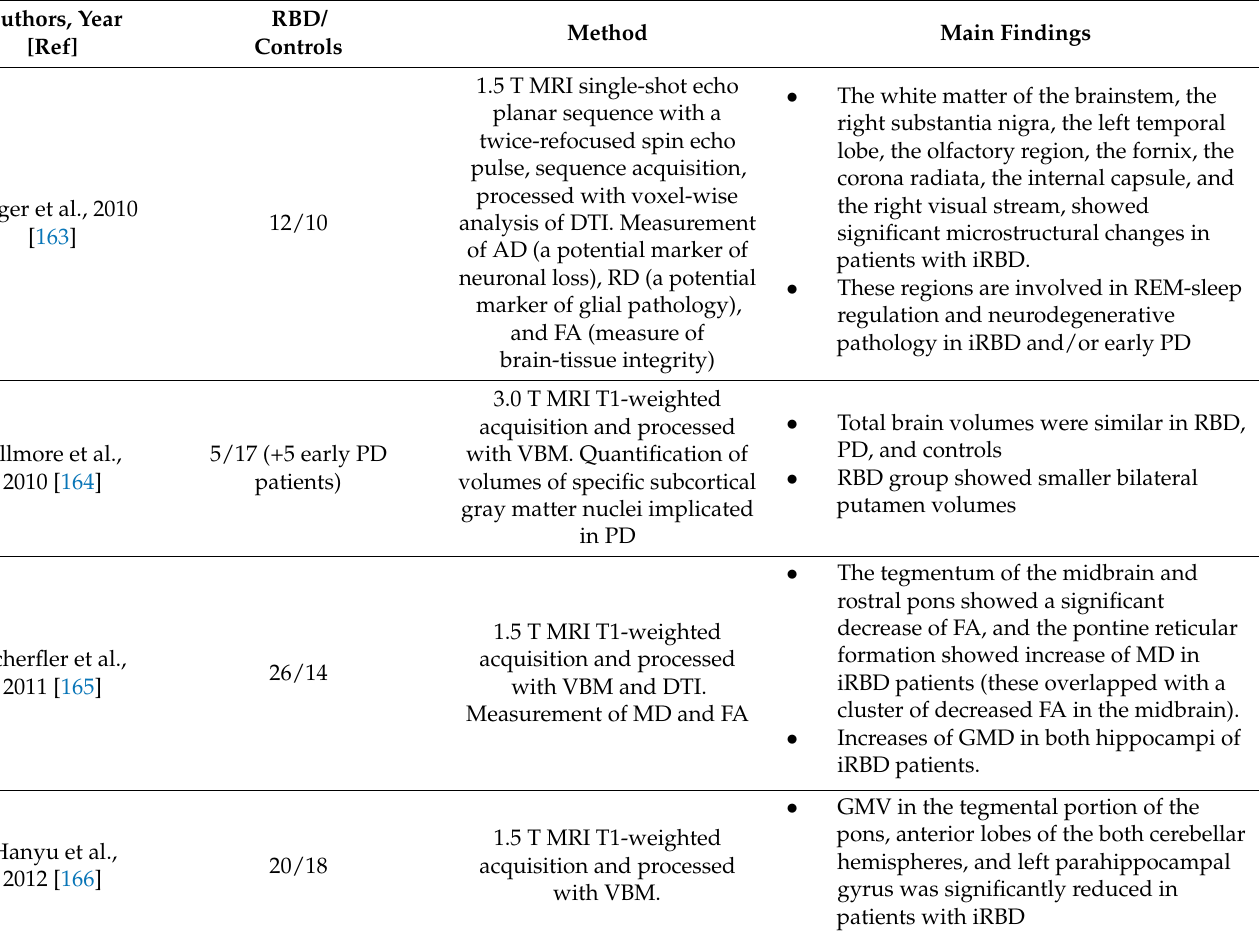
Table 4. Results of structural and functional neuroimaging in patients with REM sleep behavior disorder (RBD). AD axial diffusivity; ALFF amplitude of low-frequency fluctuations; BG basal ganglia; BOLD blood oxygen level-dependent; BS brainstem; CSO centrum semiovale; DAT dopamine transporter; DBM deformation-based morphometry; DFC dynamic functional connectivity; DNH dorsal nigral hyperintensity; DTI diffusion tensor imaging; EPVS enlarged perivascular space; FA fractional anisotropy; fMRI functional MRI; GE-EPI gradient echo planar imaging; GM gray matter; GMD gray matter density; GMV gray matter volume; iRBD idiopathic RBD; MCI mild cognitive impairment; MD mean diffusivity; MRI magnetic resonance imaging; MVPA multivariate pattern analysis; NM neuromelanin; PD Parkinson’s disease; RBD REM sleep behavior disorder: RD radial diffusivity; ReHo regional homogeneity; SN substantia nigra; SWI susceptibility- weighted imaging; T Tesla; TIV total intracranial volume; VBM voxel-based